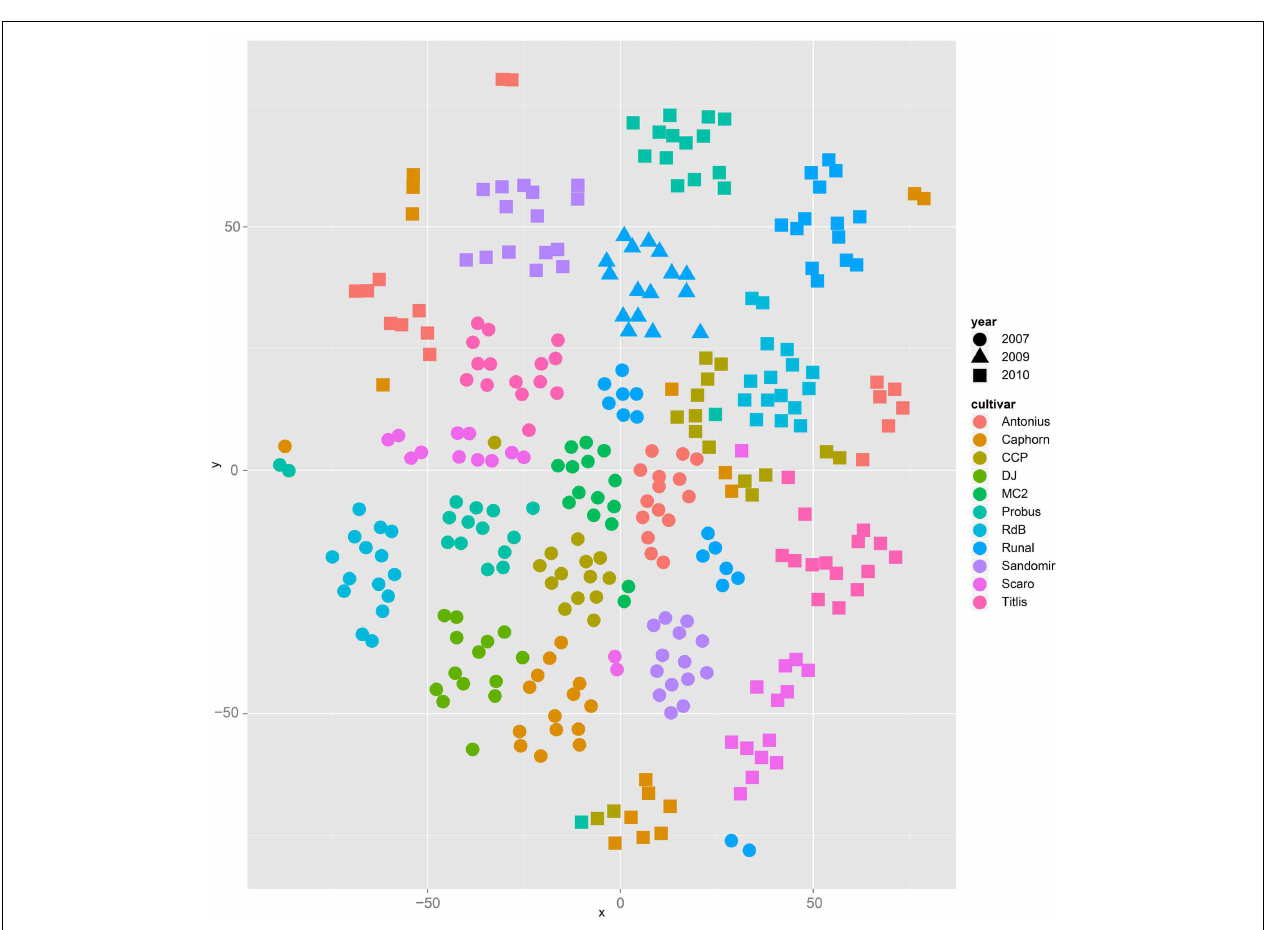
FIGURE 5 |The t-SNE method applied to all samples results in clusters and sub clusters formed according to the factor year and cultivar, respectively